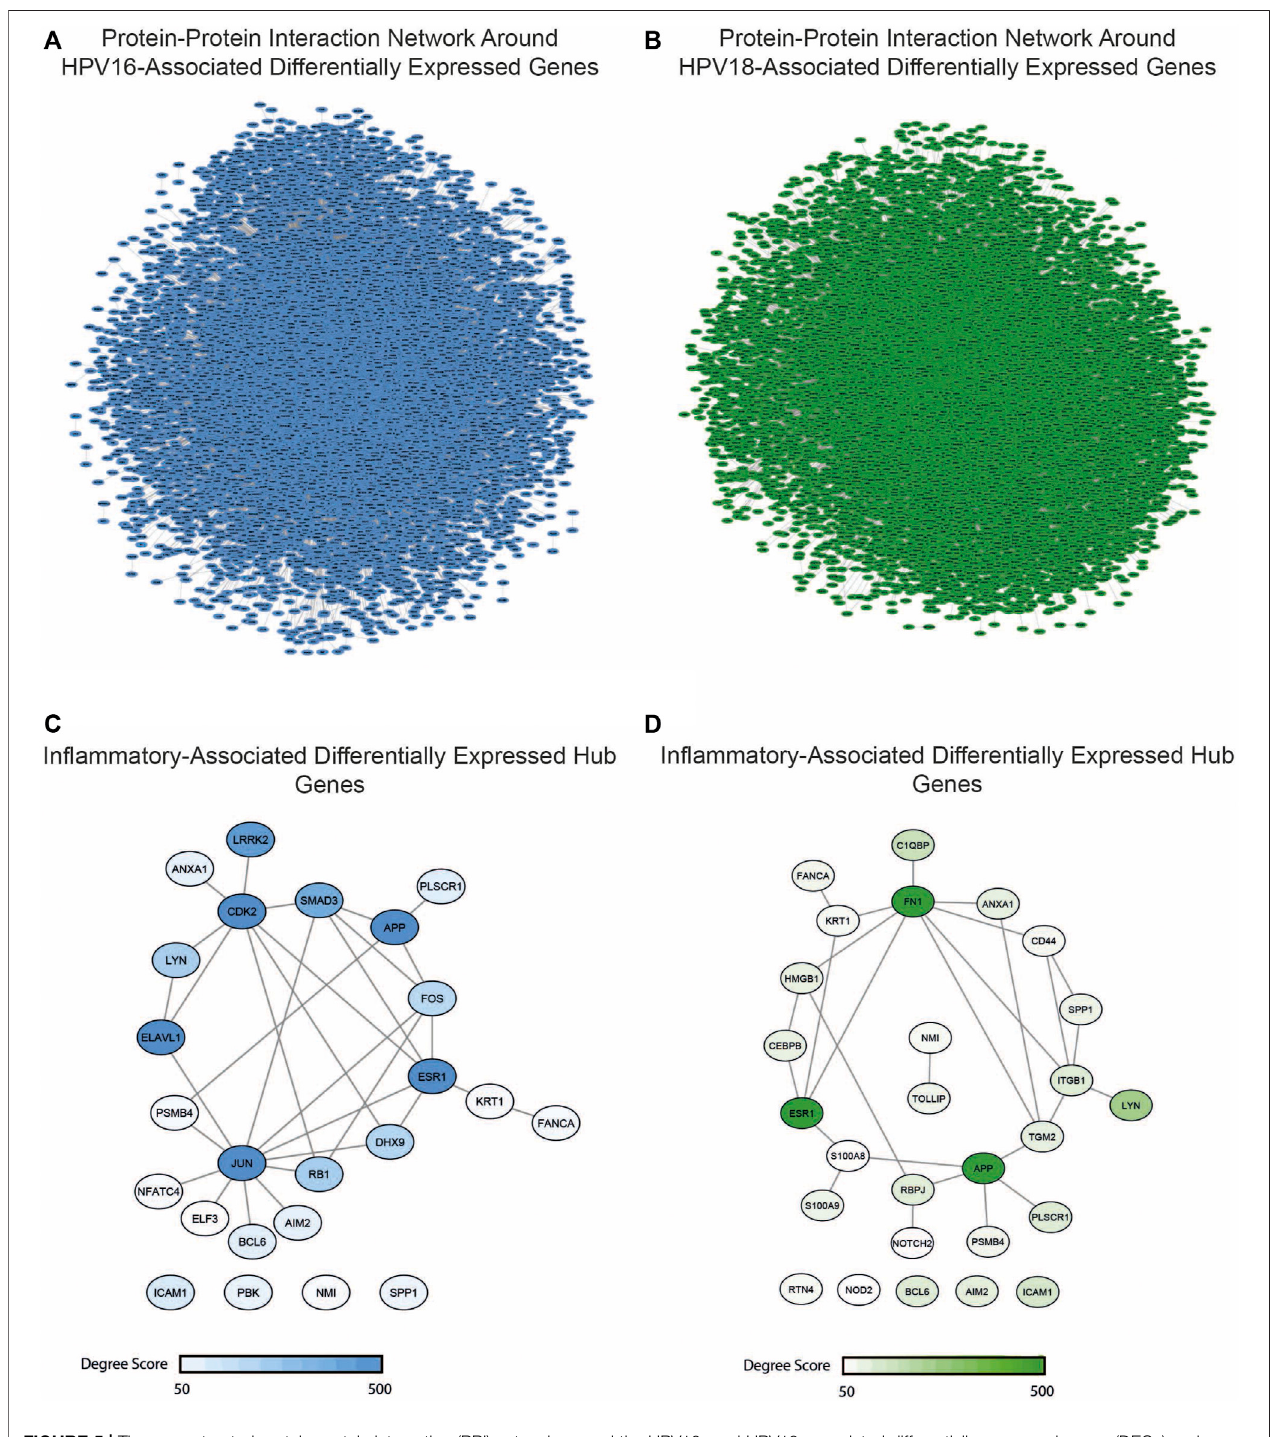
FIGURE 5 | The reconstructed protein-protein interaction (PPI) network around the HPV16- and HPV18-associated differentially expressed genes (DEGs) and in fl ammatory-associated hub DEGs. (A) The reconstructed PPI network around HPV16-associated DEGs (B) The reconstructed PPI network around HPV16- associated DEGs (C) The anti-in fl ammatory and HPV16 associated hub DEGs which colored according to degree score signi fi cance (D) The anti-in fl ammatory and HPV18 associated hub DEGs which colored according to degree score signi fi cance.